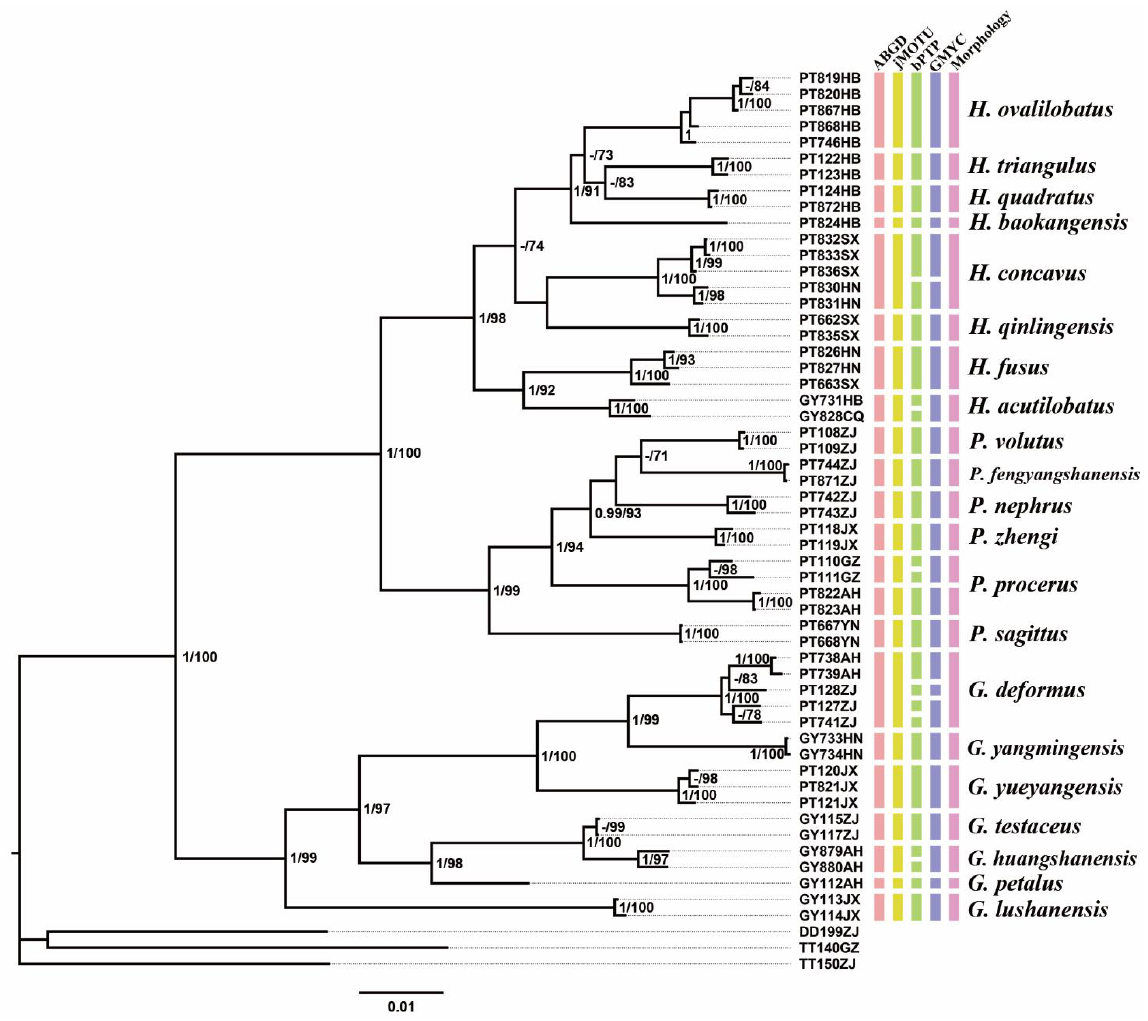
Figure 1. BI tree of Gymnaetoides , Pseudotachycines, and Homotachycines . The numbers at the nodes are Bayesian posterior probabilities (PP) and maximum likelihood bootstrap support values (BS). PP > 0.95 or BS > 70 are given at the nodes. In ML tree, PT868HB is recovered as sister to PT746HB (BS = 92) and together they are sister to PT819HB, PT820HB, and PT867HB (BS = 100). Results of molecular species delimitation based on ABGD, jMOTU, bPTP, GMYC, and morphological species are annotated on the right side of the